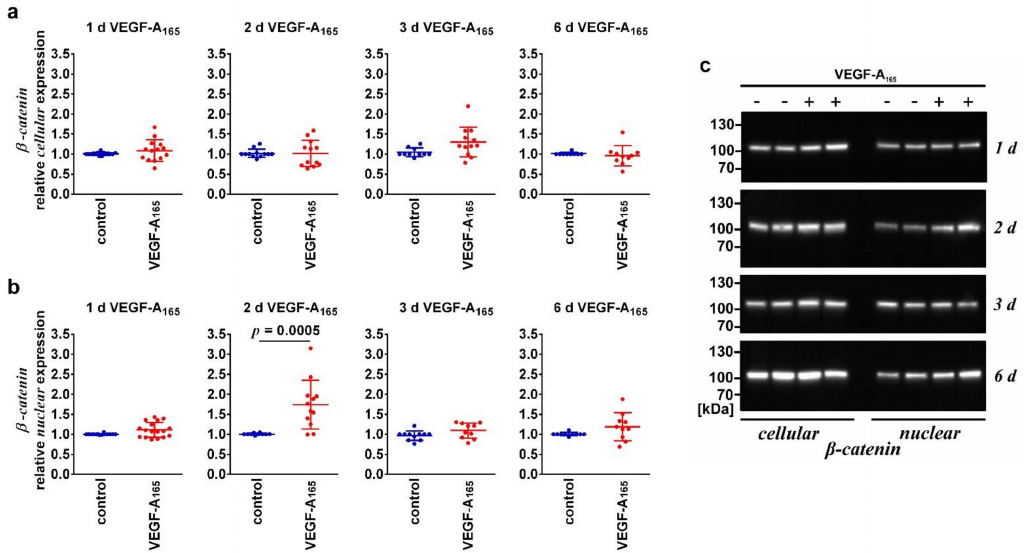
Figure 2. Nuclear expression levels of β -catenin changed over time of exposure to VEGF-A 165 . Confluent iBREC were exposed to VEGF-A 165 and cells were harvested one to six days later for preparation of ( a ) cellular and ( b ) nuclear extracts and subsequent Western blot analyses of which representative images are shown in ( c ). Levels of ( a ) cellular β -catenin remained unchanged by VEGF-A 165 but ( b ) those of nuclear β -catenin were significantly elevated only on day 2. Signals obtained by Western blot analyses were normalized and analyzed as described above. Please refer to Figure S2 for original images.